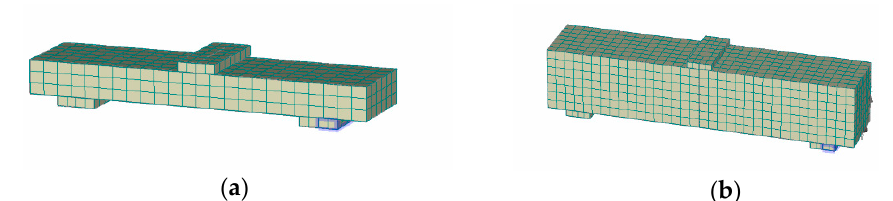
Figure 11. Numerical models for UHPFRC-1 prisms ( a ) 25 × 90 × 360 mm and ( b ) 100 × 100 × 500 mm.